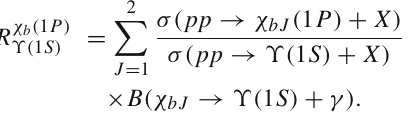
Fig. 7 Transverse momentum distribution of the inclusive ϒ( 1 S ) pro- √ s = 7TeV(upperhistograms)and ductioncalculatedat (lower histograms, divided by 100) in the different rapidity regions. The